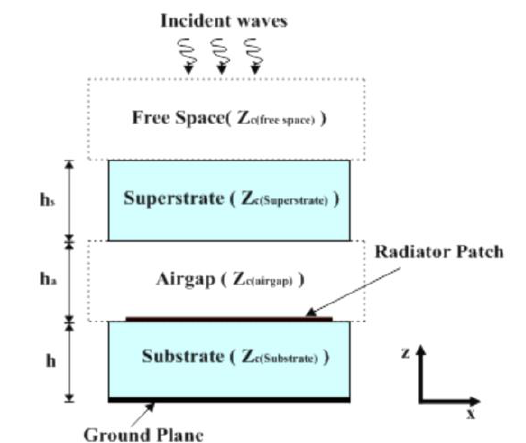
Figure 5. Equivalent Transmission line model of the suggested antenna structure (fig. 3)